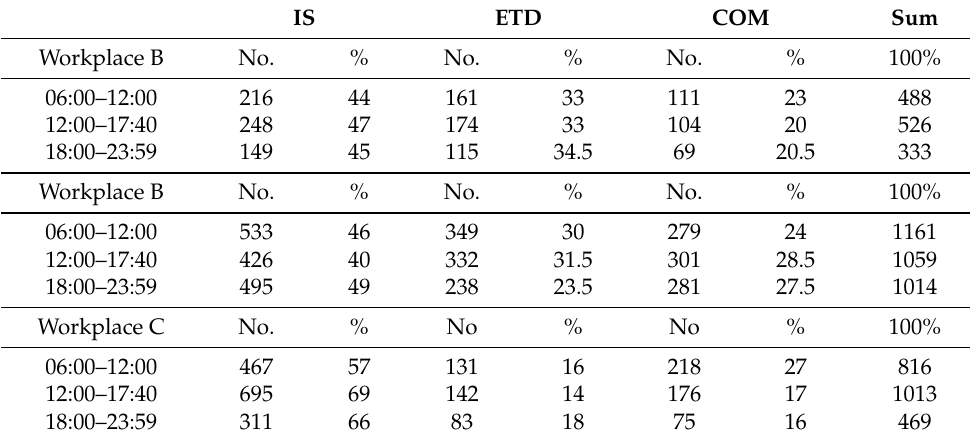
Table 8. Distribution of operator’s actions.